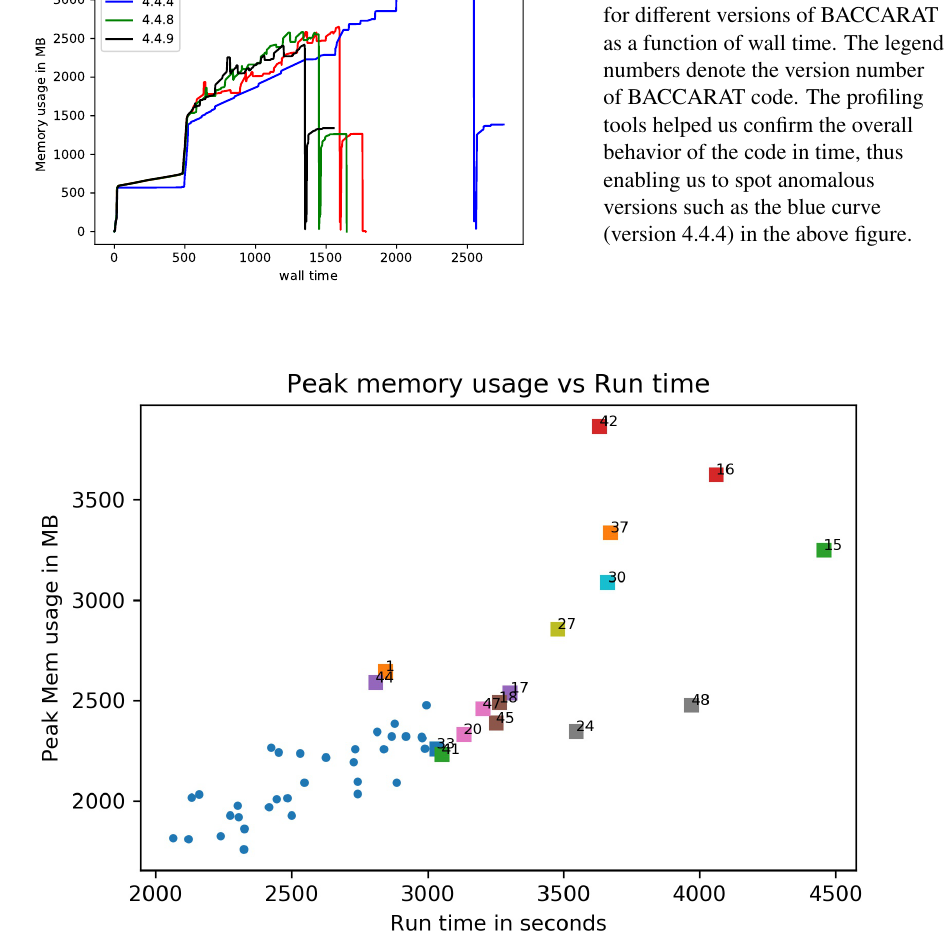
Figure 2. Memory usage in MB for